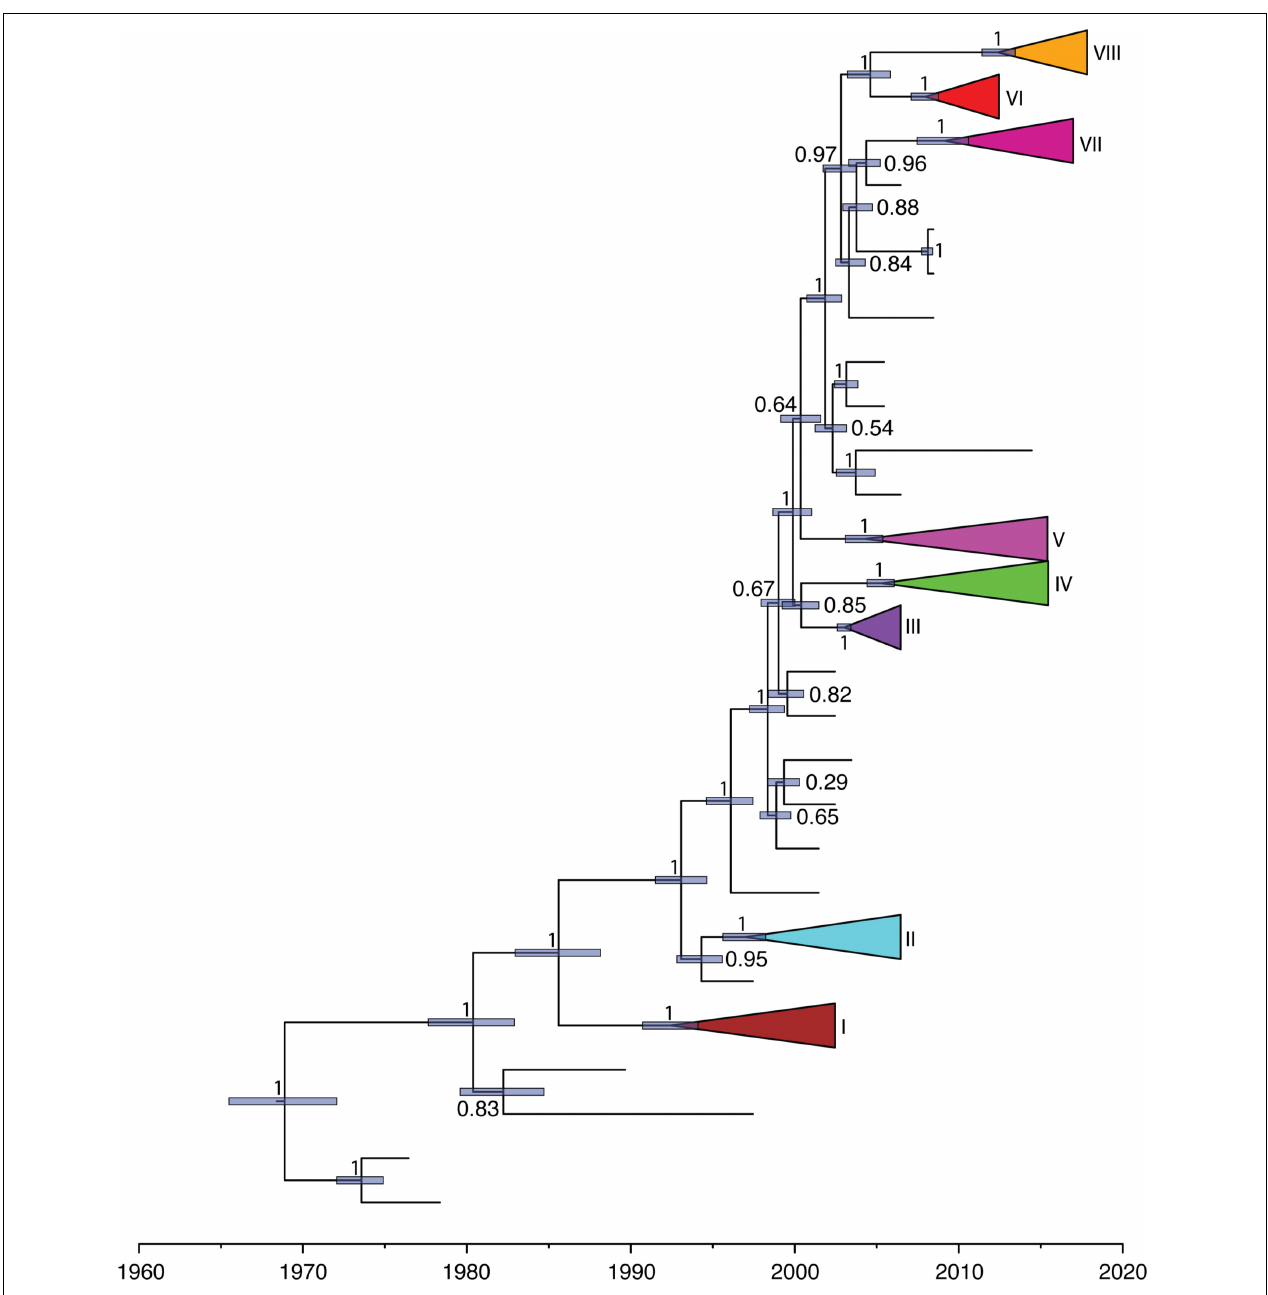
FIGURE 5 | Maximum-clade-credibility tree estimated from complete VP1 gene sequences of HuNoV GII.2. Light blue horizontal bars represent 95% credibility intervals for estimates of node times. Posterior probabilities are shown at the node. Each cluster is shown with different colors.